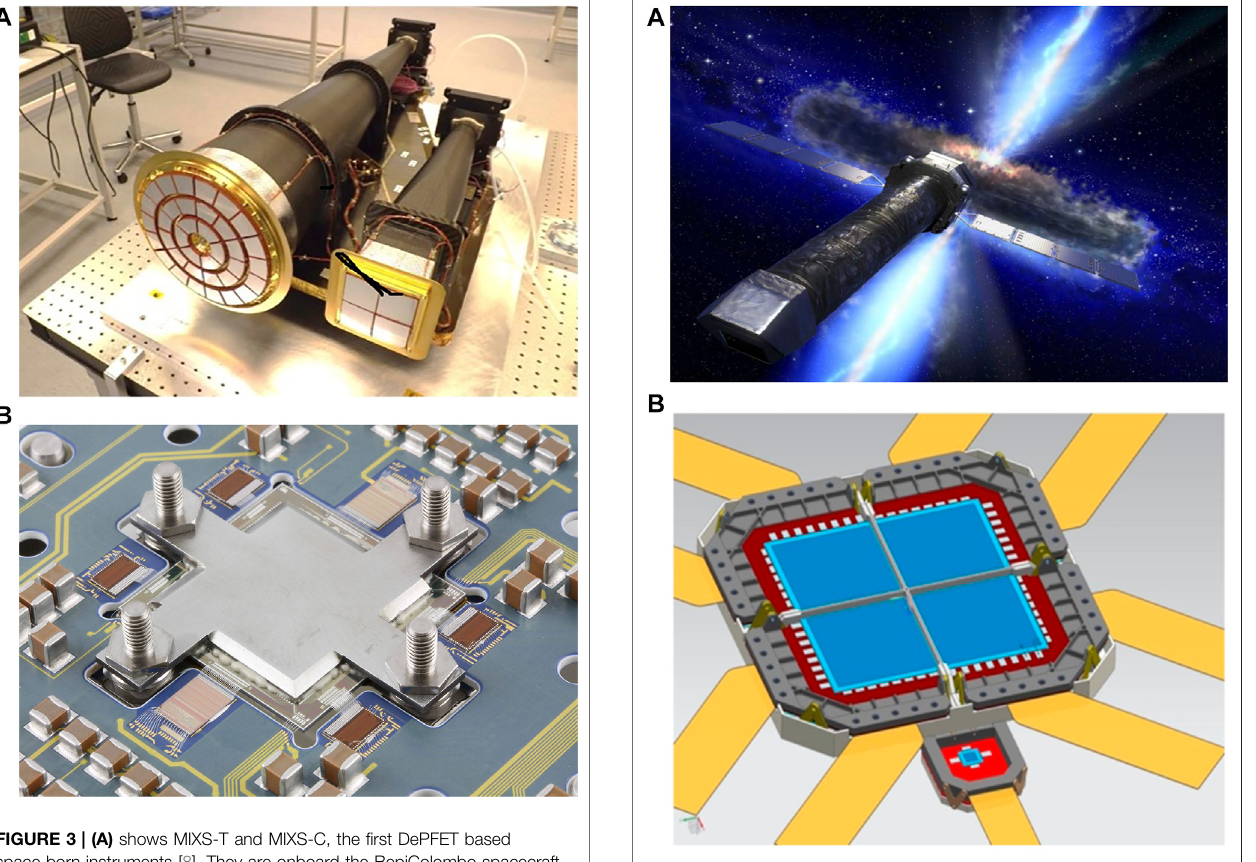
FIGURE 4 | (A) shows an artist ’ s impression of the advanced telescope for high energy astrophysics (Athena) (copyright: European Space Agency (ESA)). Athena will have two instruments in its focal plane, one of the two instruments is the WFI. As shown in (B) the WFI will consist of a large sensor array comprised of 4 512 × 512 DePFET sensor matrices and one small sensor optimized for high count rates